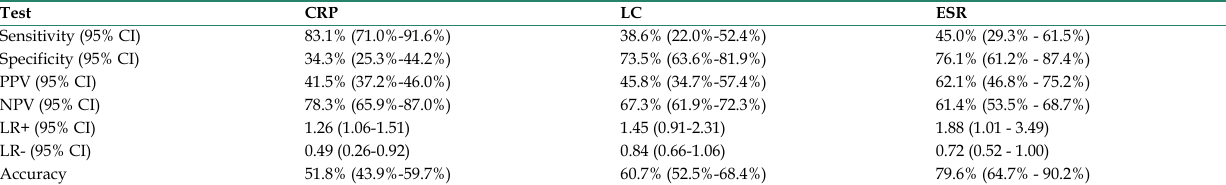
Table 4. Diagnostic accuracies for CRP, LC and